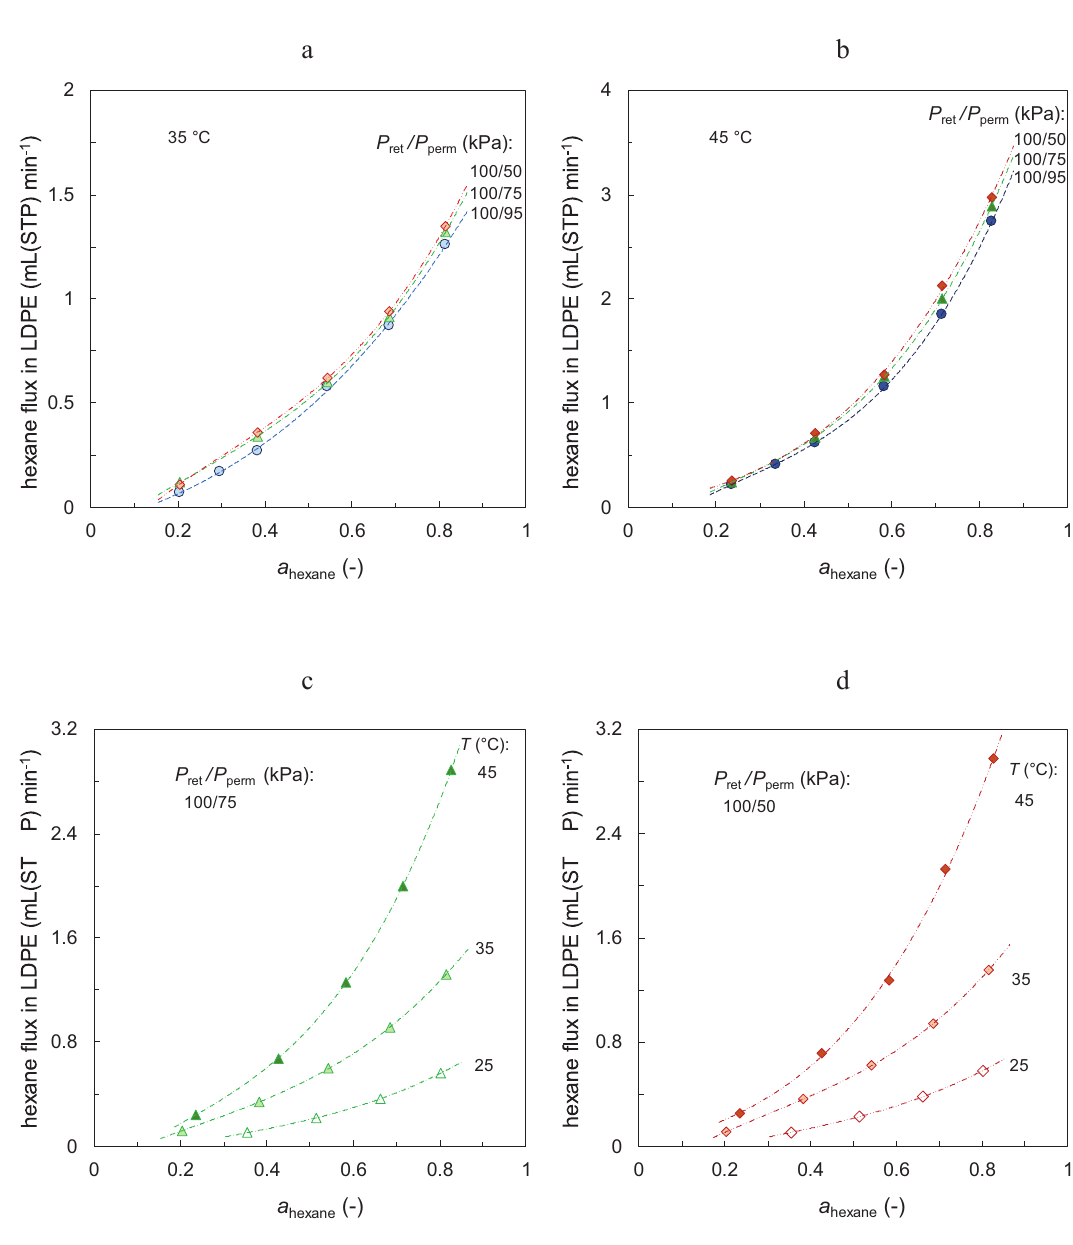
Figure S1 Fig. S1 – Hexane flux in LDPE membrane: activity dependence at three different trans-membrane pressures at a) 35 °C and b) 45 °C, activity dependence at three temperatures at trans-membrane pressure c) 25 kPa and d) 50 kPa; The lines are intended as a guide to the eye.